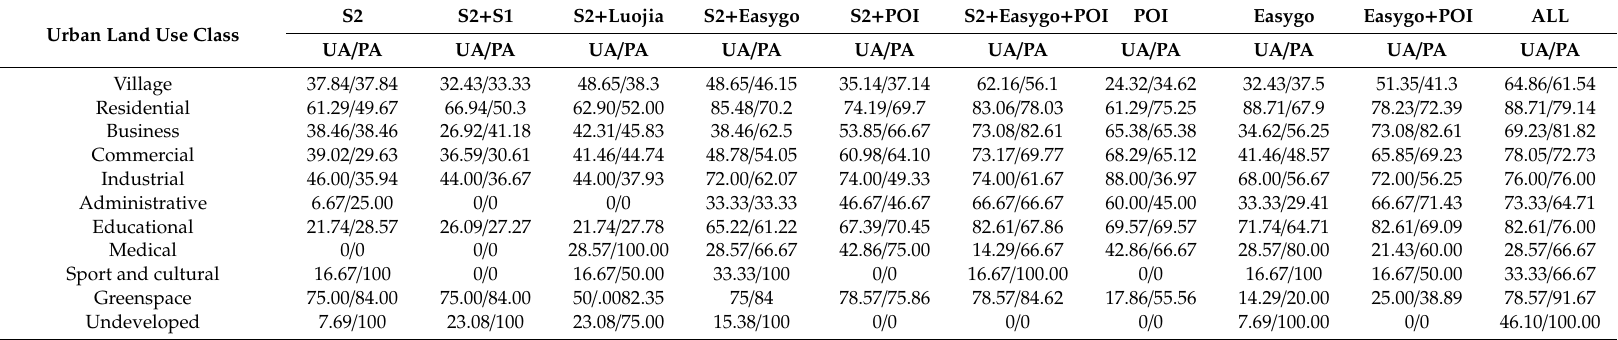
Table A1. User accuracy and producer accuracy of di ff erent land use classes based on di ff erent feature combinations (Level II